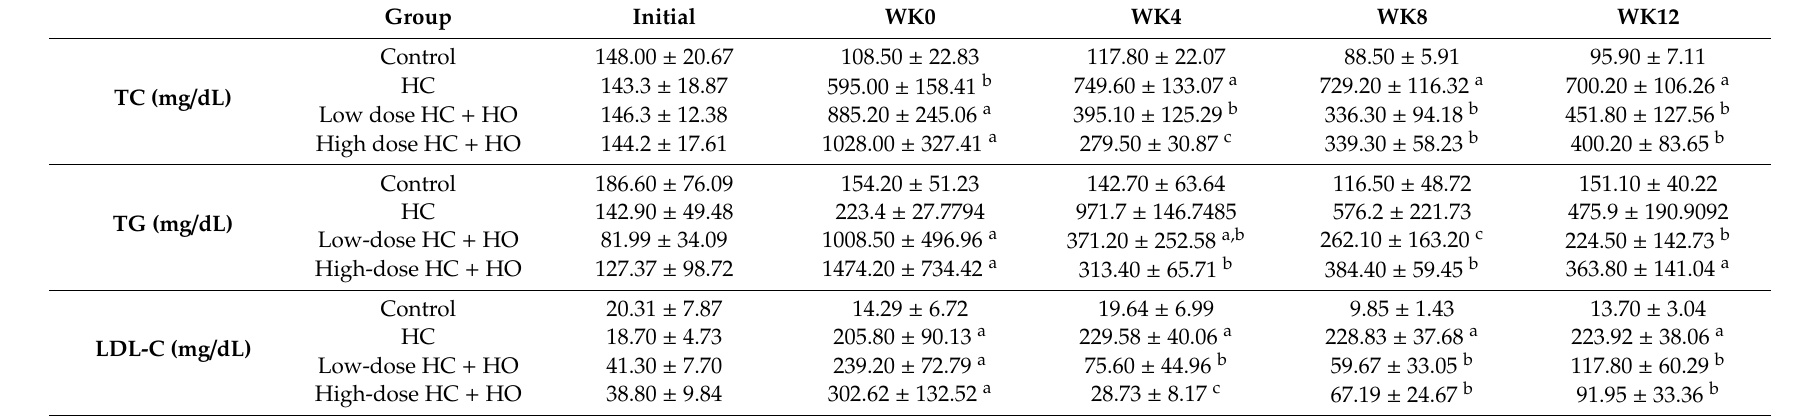
Table 4. Serum lipid profile in di ff erent